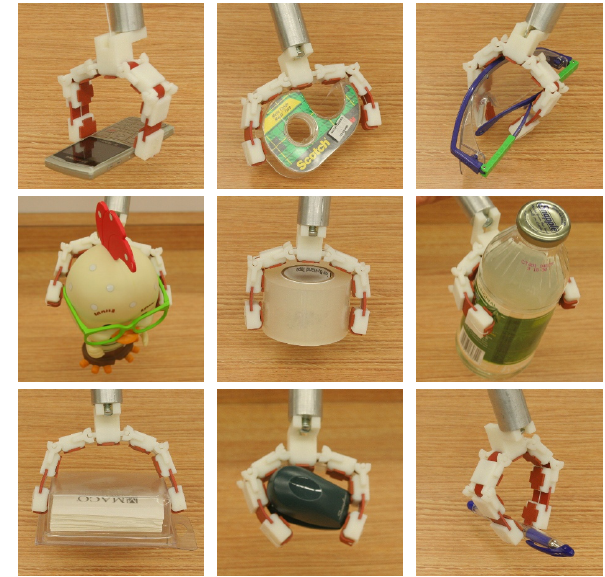
Fig. 8. GRASPS EXECUTED WITH THE PROTOTYPE GRIP- Figure 8. Grasps executed with the prototype PER.